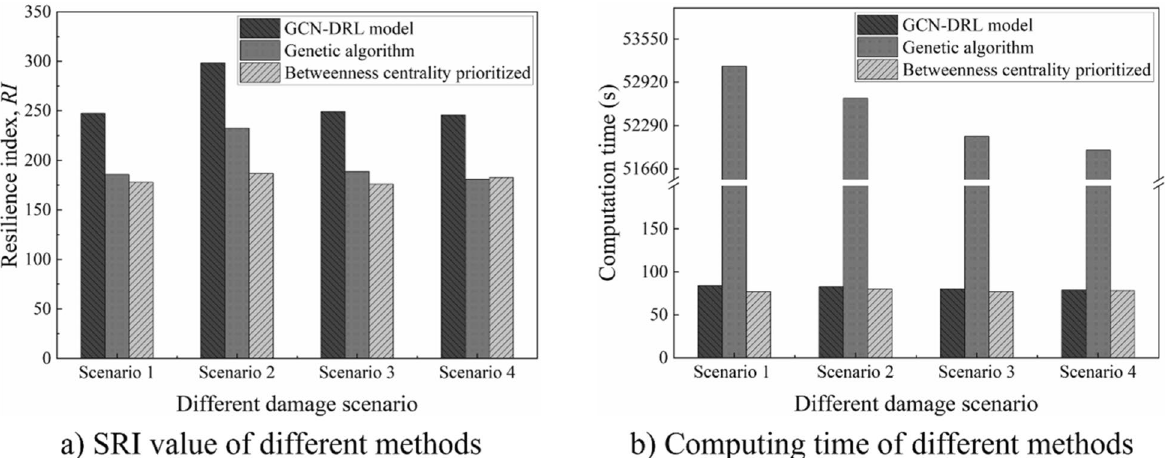
Fig 16 Comparison of the performance of post-flood road network recovery decisions by three different methods a SRI values of the road network b the computational